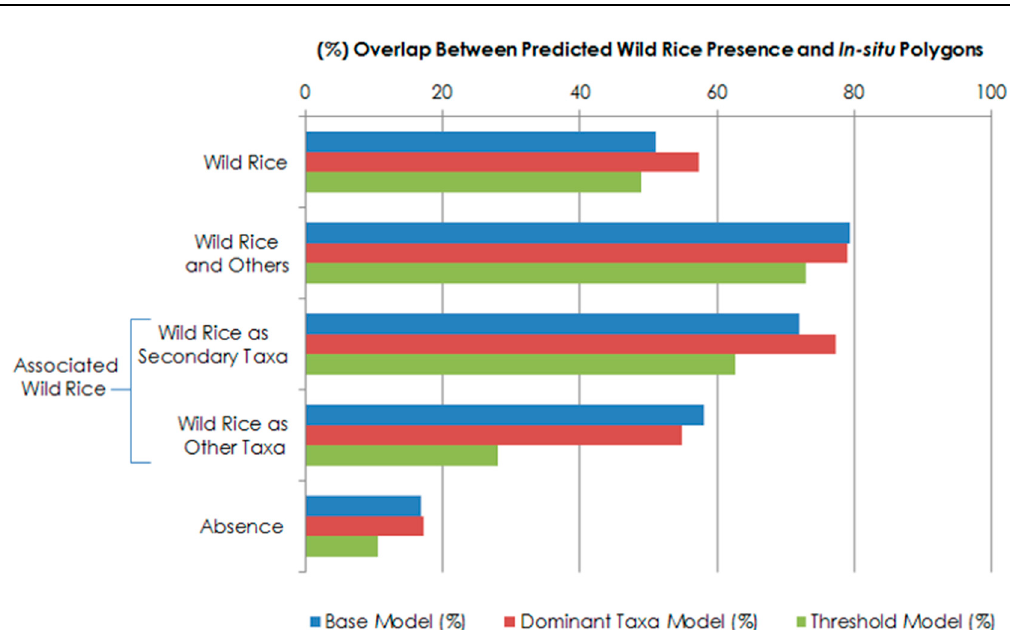
Figure 5. Percent overlap between model predictions and in-situ polygons covering at least half the area of a pixel (30 m). Reference in-situ survey cover definitions in Table 1 to clarify the species included in each class with respect to their proportion of cover and dominance. Note that wildrice does not comprise the full area surveyed for any of the classes and therefore will not constitute 100% of the total area for any of the model predictions. Results based on validation over 30 lakes.